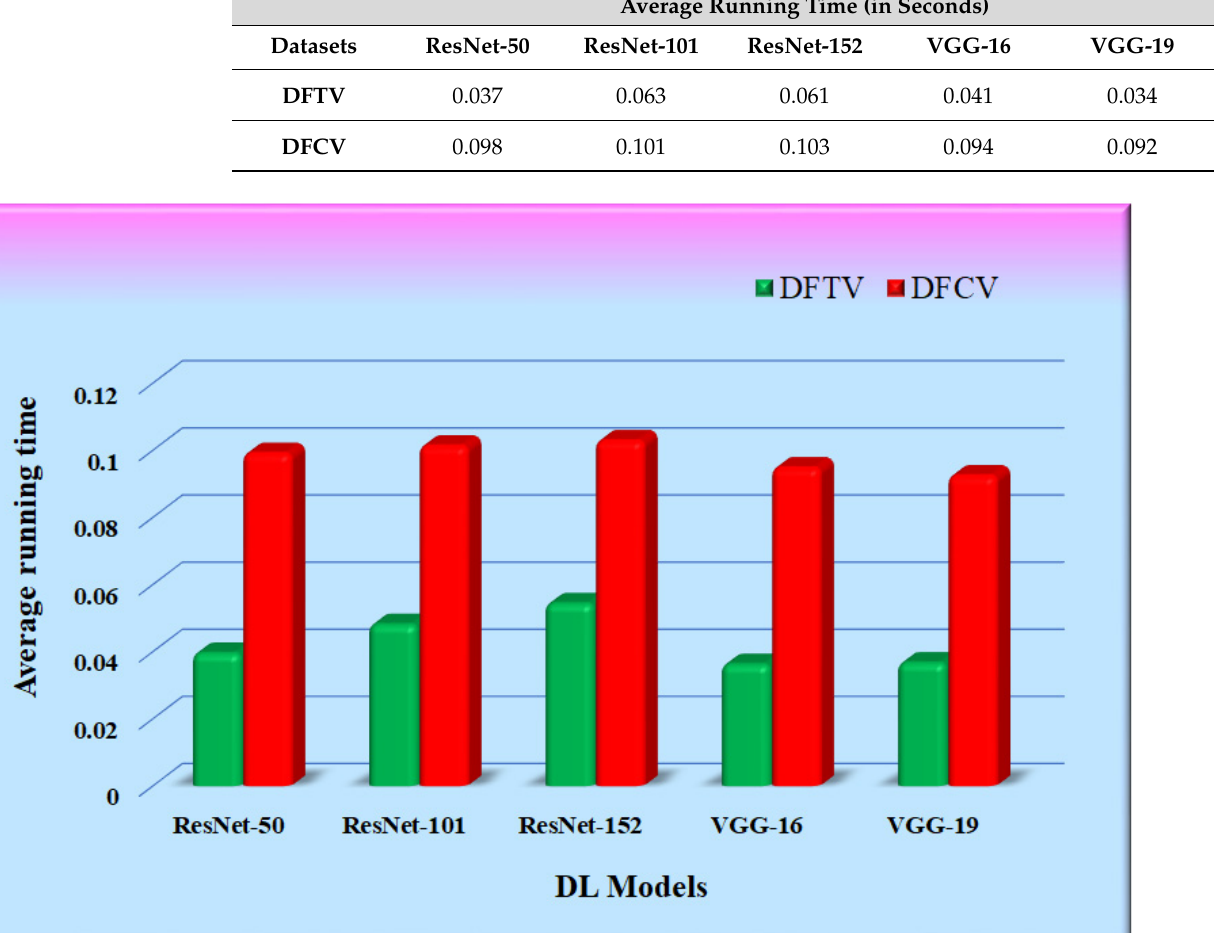
Table 7. Average running time obtained for the CNN models.